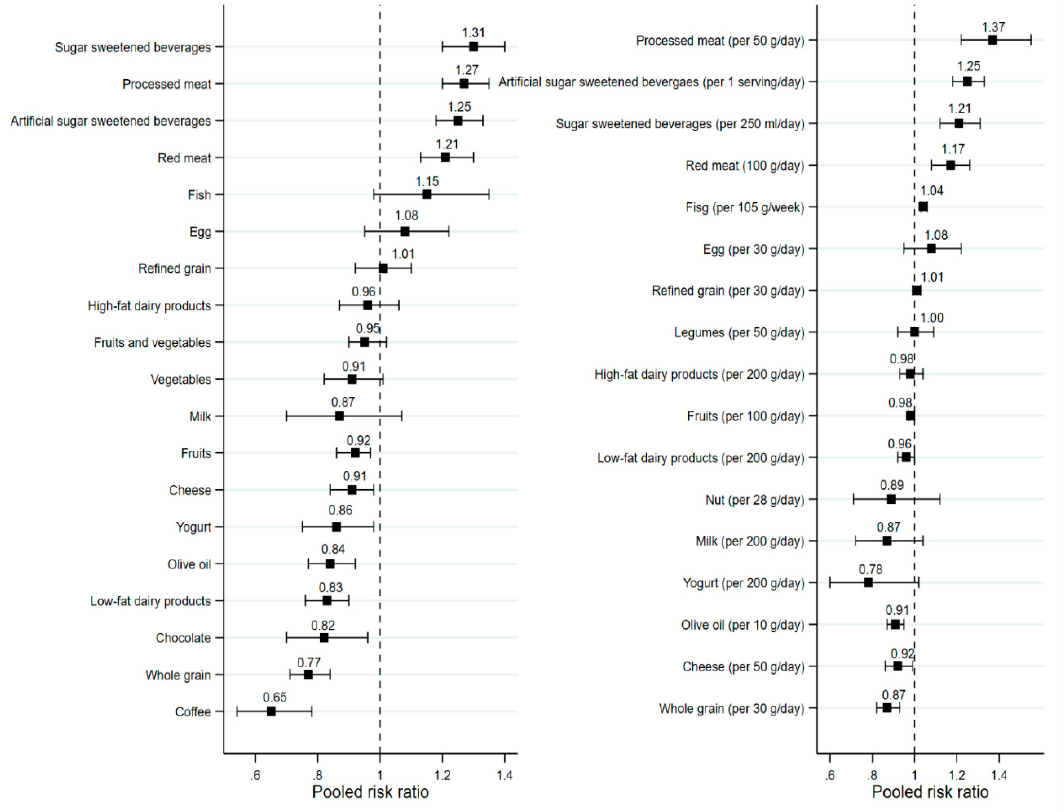
Figure 2. Pooled risk ratios of food groups and risk of T2DM. ( A ) Highest versus lowest category comparison. ( B ) Dose-response analysis.